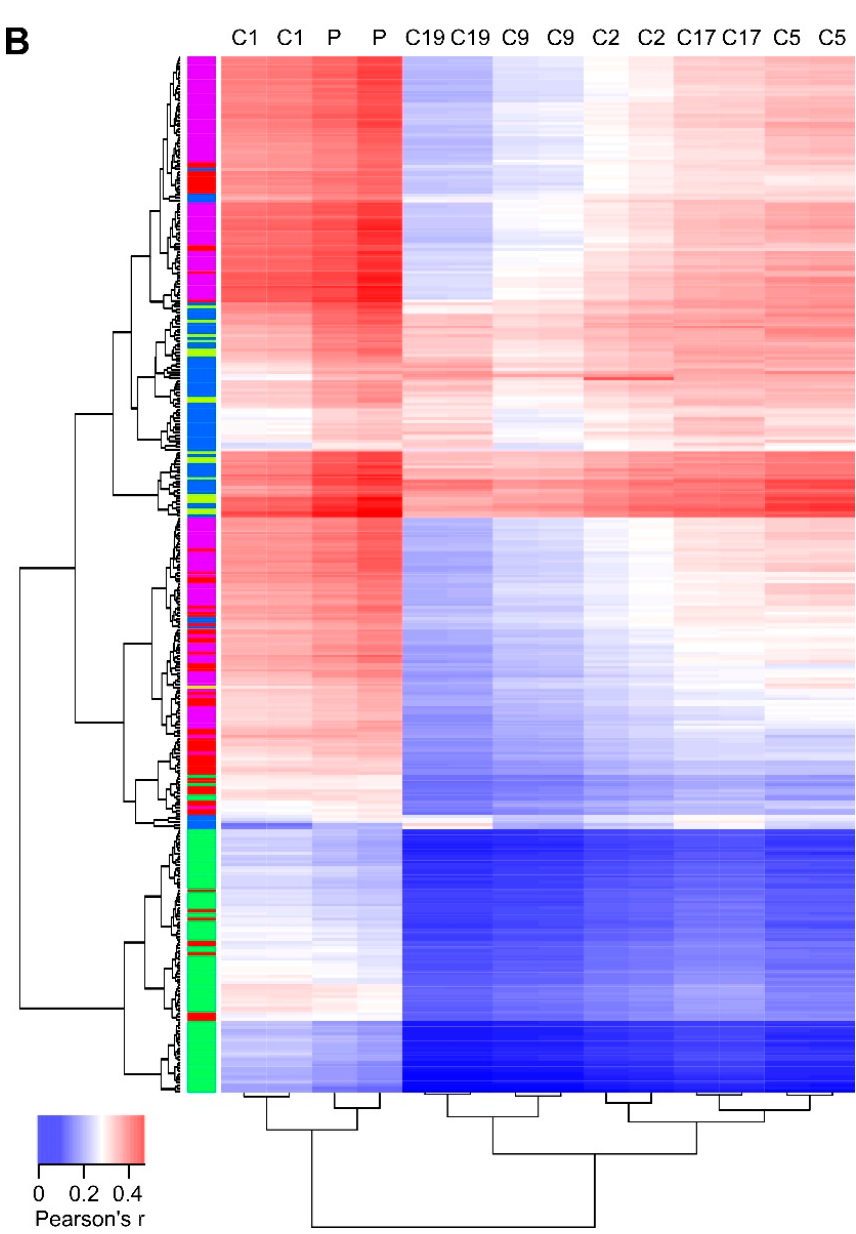
Figure 8. Neural crest single cell differentiation analysis. Single-cell gene expression data from Furlan et al. [53] (E13.5) were correlated to the expression of the clones used in this study. ( A ) Each dot represents one cell, with Pearson correlation coefficients with C19 RET KO clone shown on the y -axis and developmental timeline indicated by the x -axis. Cells are colored according to their type as indicated on top (as derived from Furlan et al.). The absence or presence of Ret , Axl and Yap1 gene expression is shown below the plot with indication of p -values (Fisher’s exact test). ( B ) Heatmap showing Pearson correlation coefficients (key on bottom left) between each clone and single cell as indicated. Rows (cells) and columns (clones, P stands for parental cells) were hierarchically clustered with dendrograms shown above and on the left of the plot. Cell type indicated on the left of the plot by color bars. See panel ( A ) for color legend.